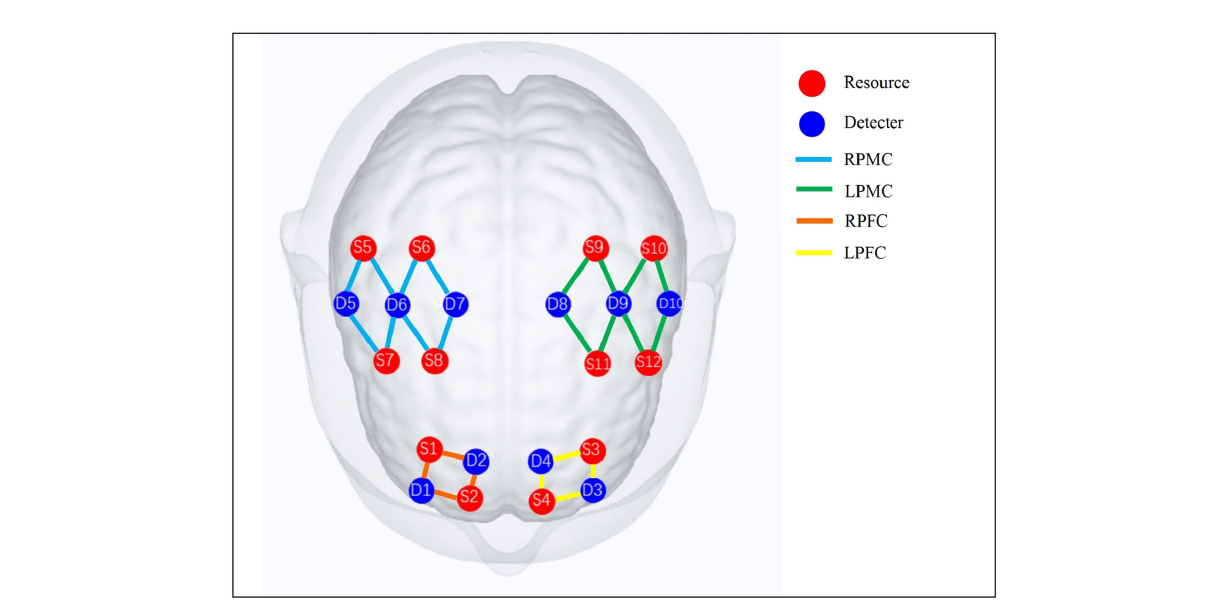
FIGURE1 fNIRS observation channel distribution and ROI division diagram. RPMC, right primary motor cortex; LPMC, left primary motor cortex; RPFC, right prefrontal cortex; LPFC, left prefrontal cortex. PMC includes primary motor cortex, anterior motor cortex, and auxiliary motor cortex; PFC includes dorsolateral prefrontal cortex and frontal pole.